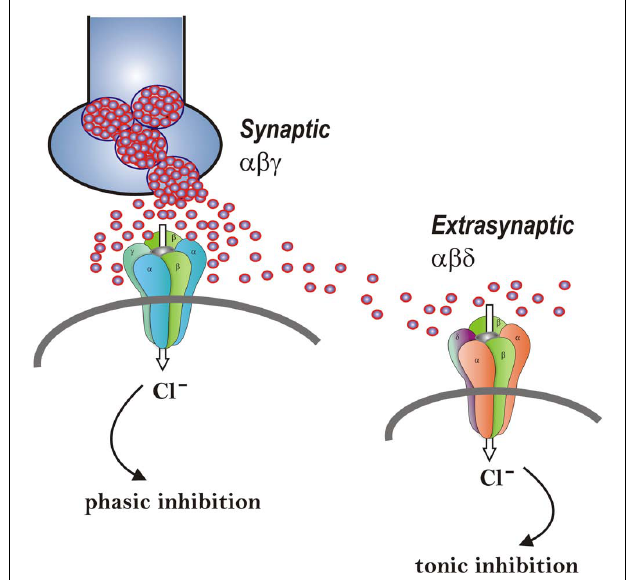
FIGURE 2 | Neurosteroid modulation of synaptic and extrasynaptic GABA-A receptors. Postsynaptic GABA-A receptors, which are pentameric chloride channels composed of 2 α 2 βγ subunits, mediate the phasic portion of GABAergic inhibition, while extrasynaptic GABA-A receptors, pentamers composed of 2 α 2 βδ subunits, primarily contribute to tonic inhibition in the hippocampus. Neurosteroids activate both synaptic and extrasynaptic receptors and enhance the phasic and tonic inhibition.Therefore, they may promote effective inhibition of seizures.Two different strategies – concomitant augmentation of both phasic and tonic inhibition and selective augmentation of tonic inhibition − are being tested in epilepsy